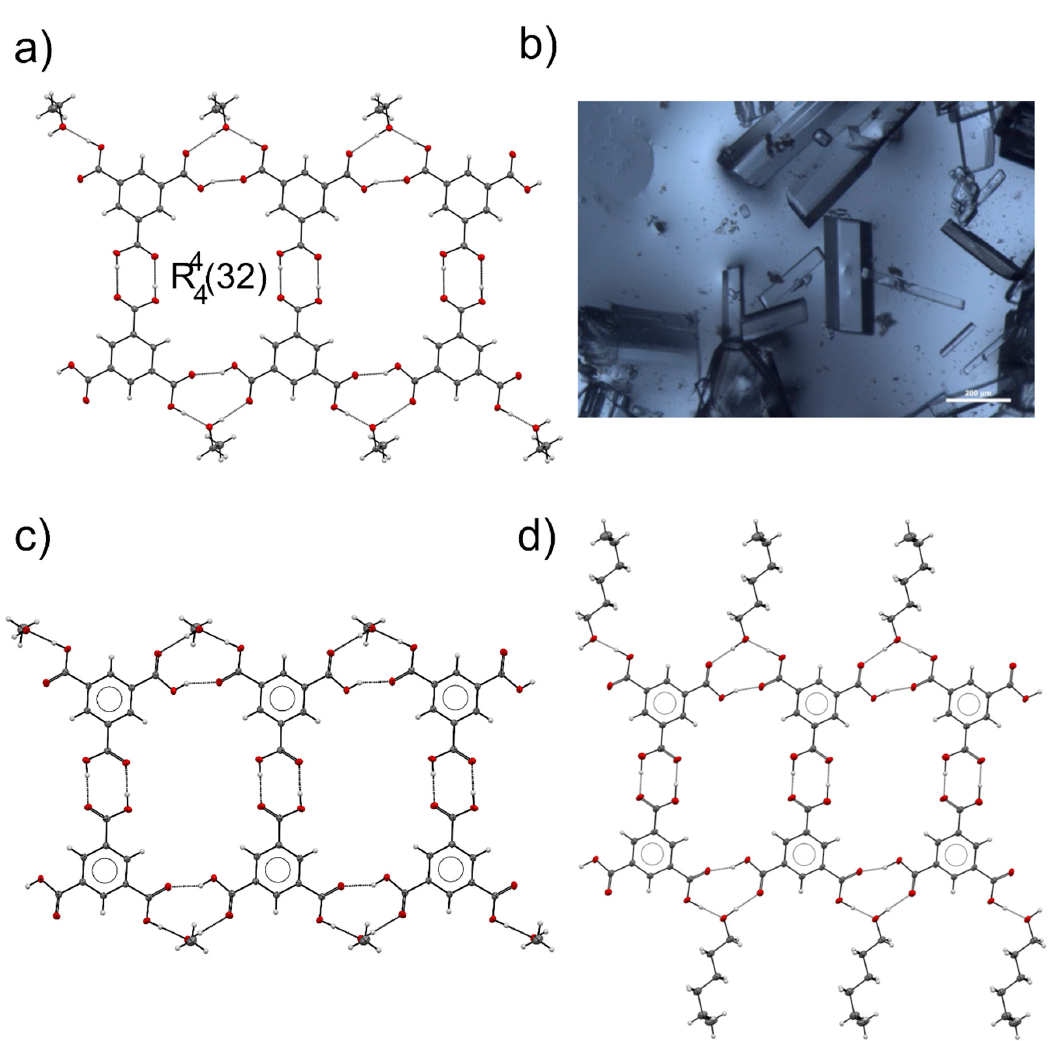
Figure 2. ( a ) The hydrogen-bonded tape of TMA molecules forming through the acid dimer R22(8) dimer that couple together to form tapes with large R44(32) rings, ( b ) crystals of TMA:ethanol solvate showing the morphology of the crystals (scale bar is 200 µm), ( c ) the tape motif observed in the methanol solvate of TMA (CSD Refcode: IYUQIC) [9]; ( d ) hexanol solvate of TMA (CSD Refcode: GIRDIV) [7].